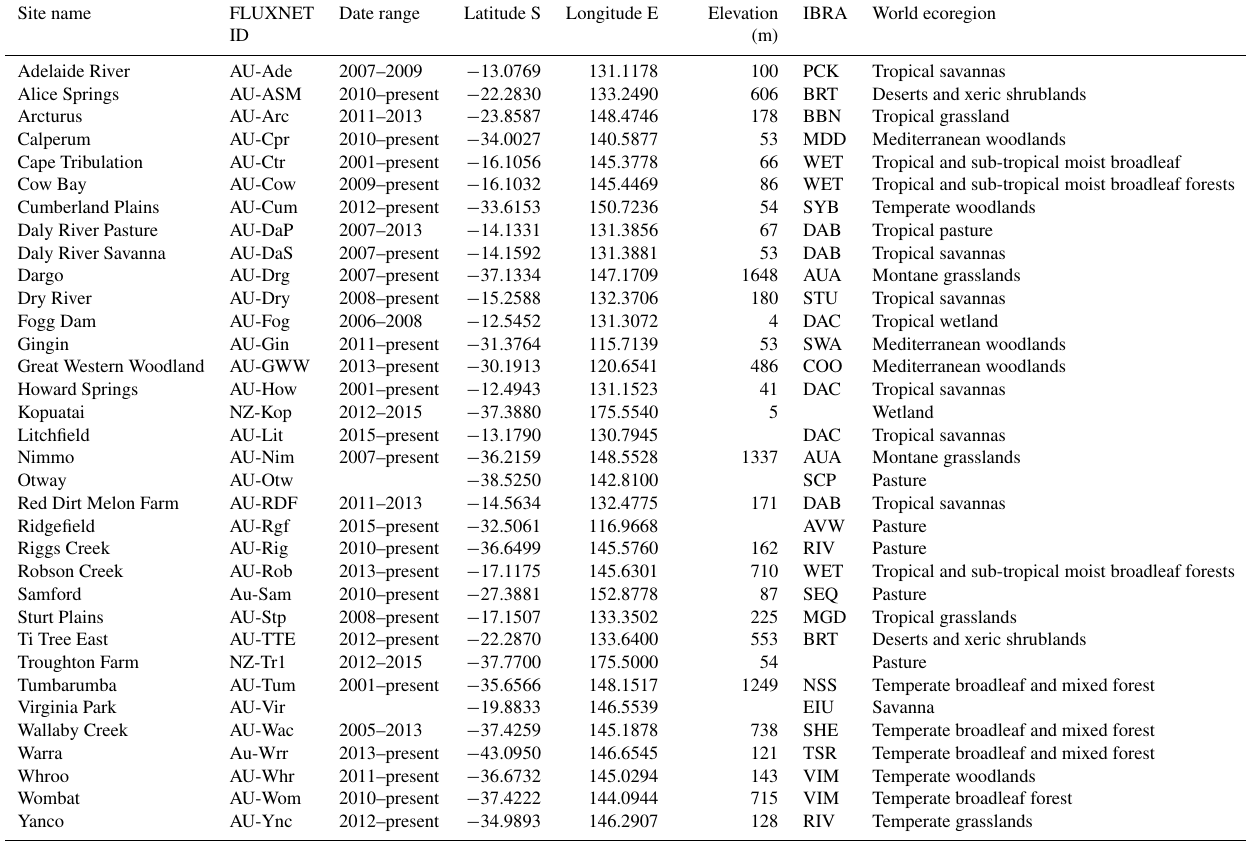
Table 1. A summary of the OzFlux tower sites along with the available data range, whilst site history is given in Supplement Table S1. The associated IBRA vegetation class is given (IBRA) along with the broader world ecoregion classification, both from the Interim Biogeographic Regionalisation for Australia v. 7 (IBRA) (Department of the Environment,